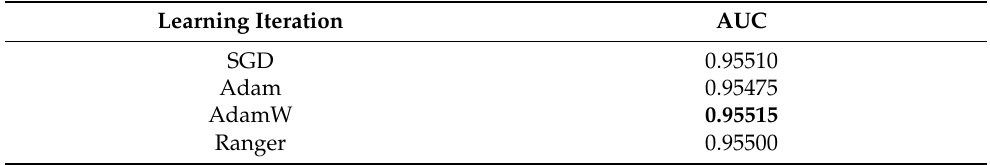
Table 5. Comparison of optimization